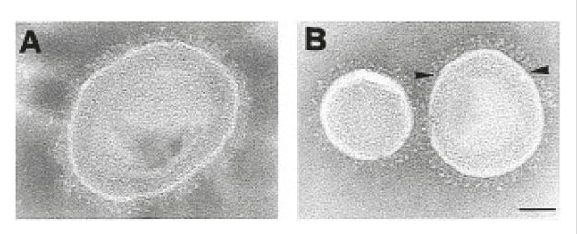
Figure 2: Cryoelectron micrographs of negatively stained DMPG/ DMPC vesicles containing integrin α IIb β 3 . Negatively stained vesicles with (A) high and (B) low surface density of integrin α IIb β 3 . The scale bar represents 100 nm. (Reprinted with permission from [40]. Copy- right (1997) American Chemical